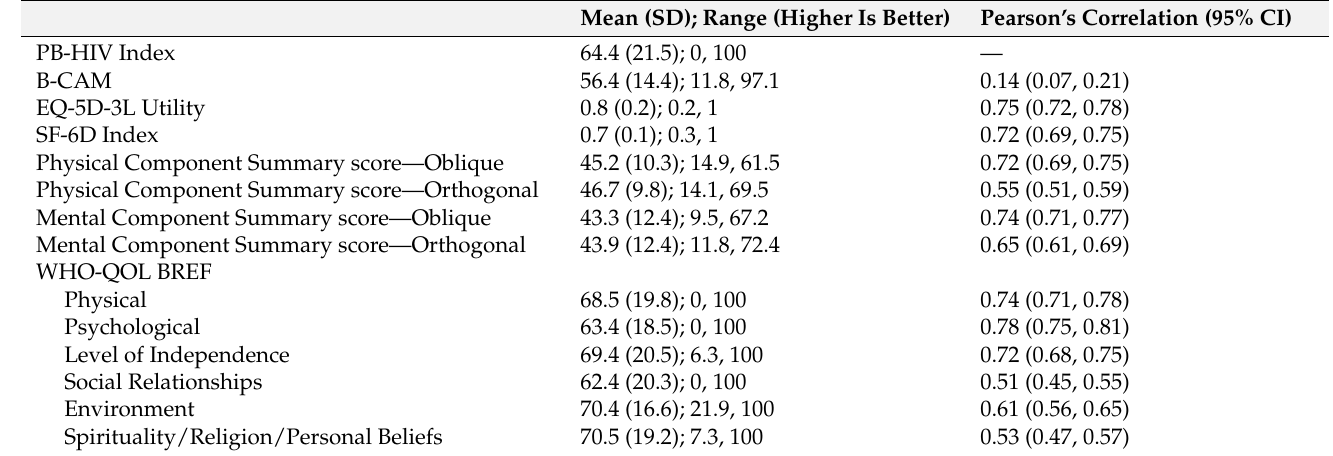
Table 3. Mean (SD) scores, correlations (95% Confidence Interval) for the PB-HIV Index and other measures of converging constructs.